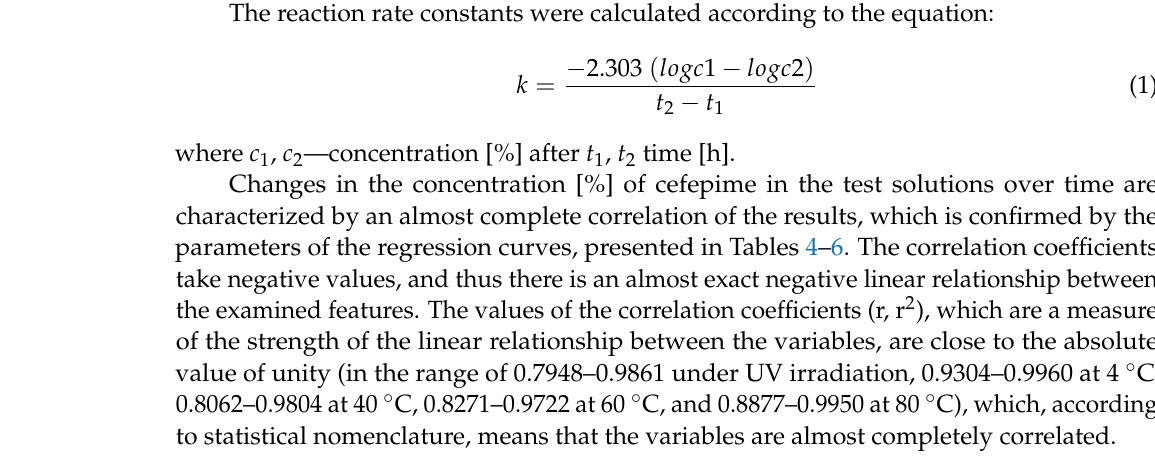
Changes in the concentration [%] of cefepime in the test solutions over time are char- The reaction rate constants were calculated according to the